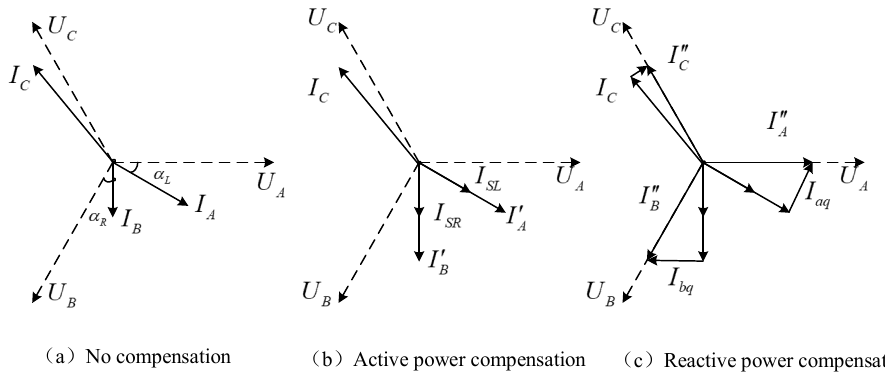
Figure 30. Power compensation vector diagram.